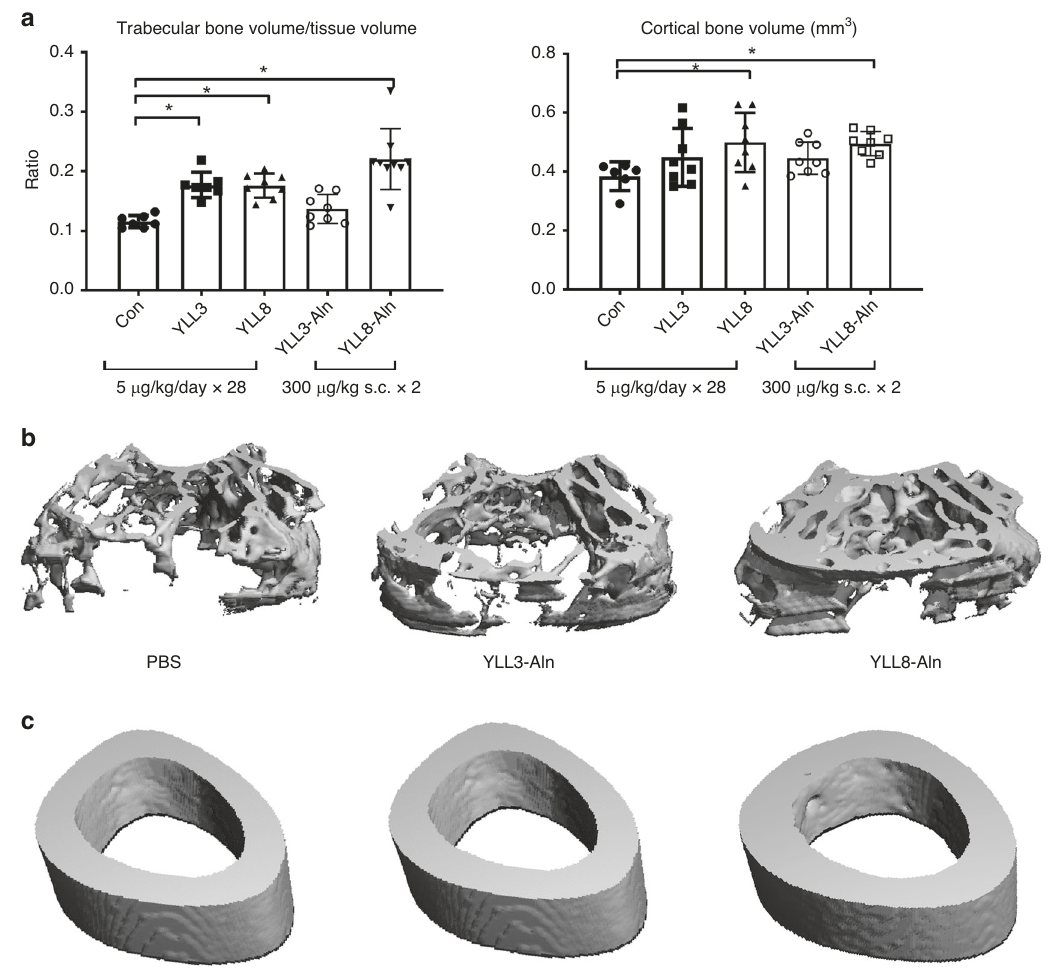
Fig. 7 YLL8-Aln increased trabecular and cortical bone mass. Two-month-old female mice were treated with PBS control, YLL3, or YLL8 at 10 μ g/kg or YLL3-Aln or YLL8-Aln at 300 μ g/kg s.c., every other week for 1 month. Mice were euthanized at day 28. a Quantitative distal femoral trabecular and middle-femur cortical bone volume measured by microCT. Columns represented individual values in each group and the error bars represented standard deviations. N = 8 animals/group. * p < 0.05 between the treated groups versus PBS-treated group using one-way ANOVA followed by Dunnett ’ s multiple comparison post hoc test. b Representative 3D images of the trabecular region taken from the distal femurs in the indicated treatment groups. c Representative images of the middle femoral cortex in indicated treatment